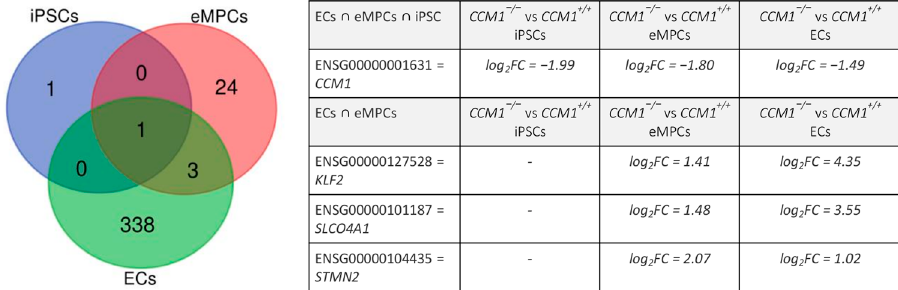
Figure 7. Overlap of differentially expressed genes in iPSCs, eMPCs, and ECs. Differential gene expression was defined as p adj < 0.05 and |log 2 FC| > 1. iPSCs = CCM1 − / − vs. CCM1 +/+ iPSCs; eMPCs = CCM1 − / − vs. CCM1 +/+ eMPCs; ECs = CCM1 − / − vs. CCM1 +/+ ECs.